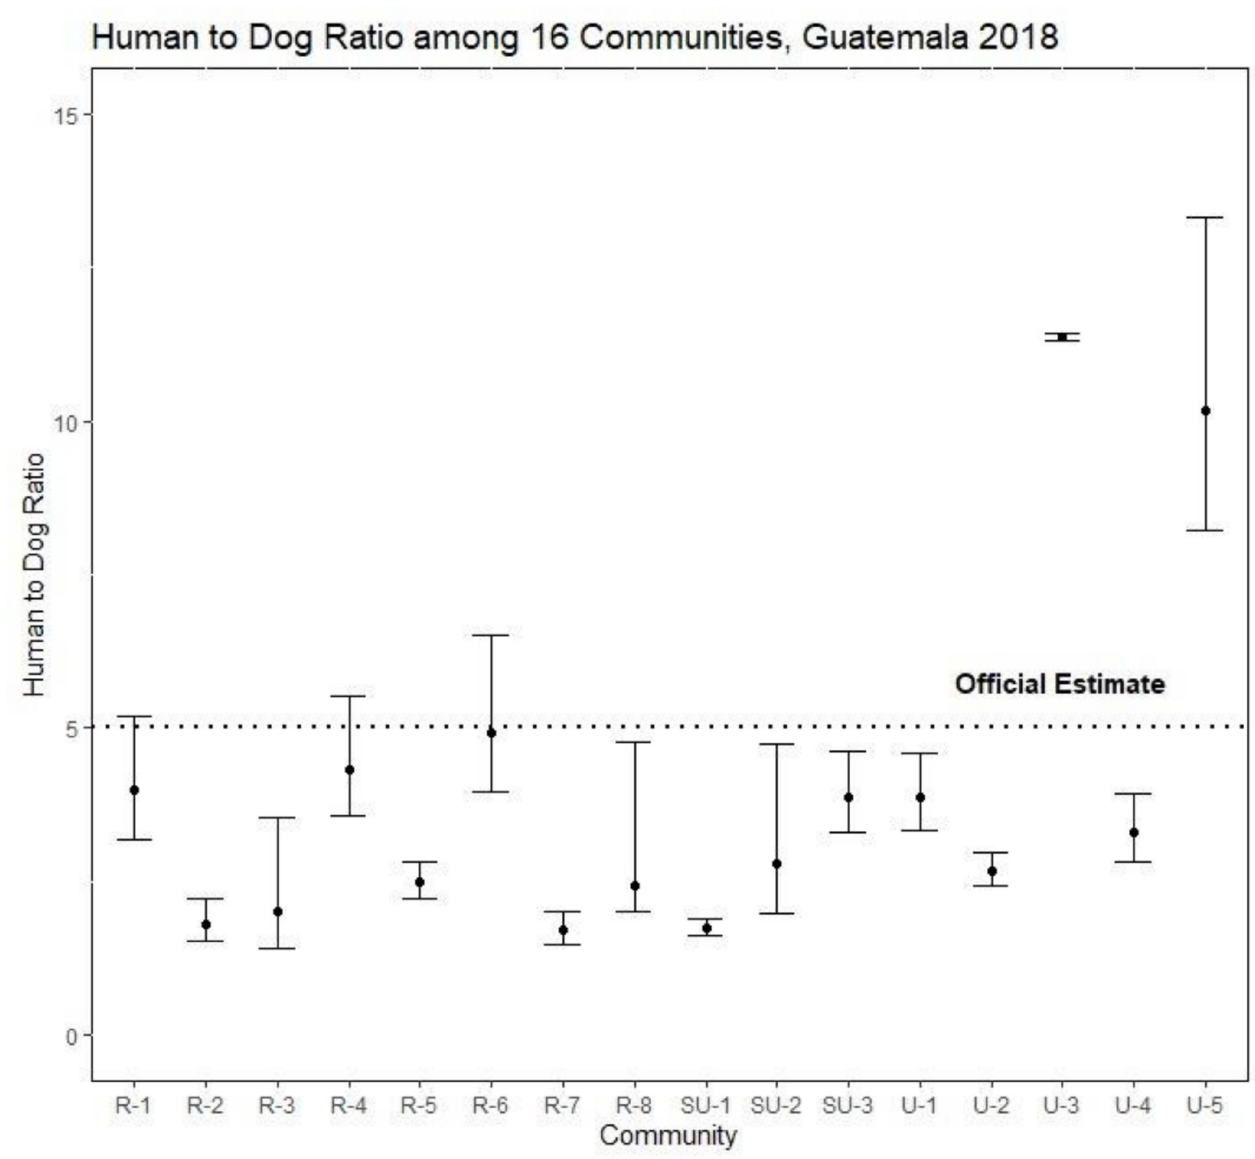
Fig 4. Comparison of the Human:Dog ratio between the different surveilled communities in this study.